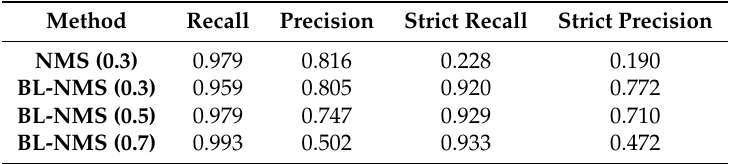
Table 3. Performance comparisons using different NMS methods and NMS thresholds.